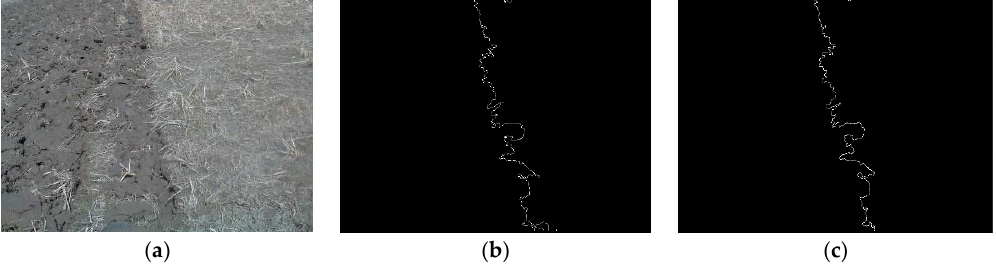
Figure 3. The edge processing comparison: ( a ) original; ( b ) edge information; ( c ) processed edge information.